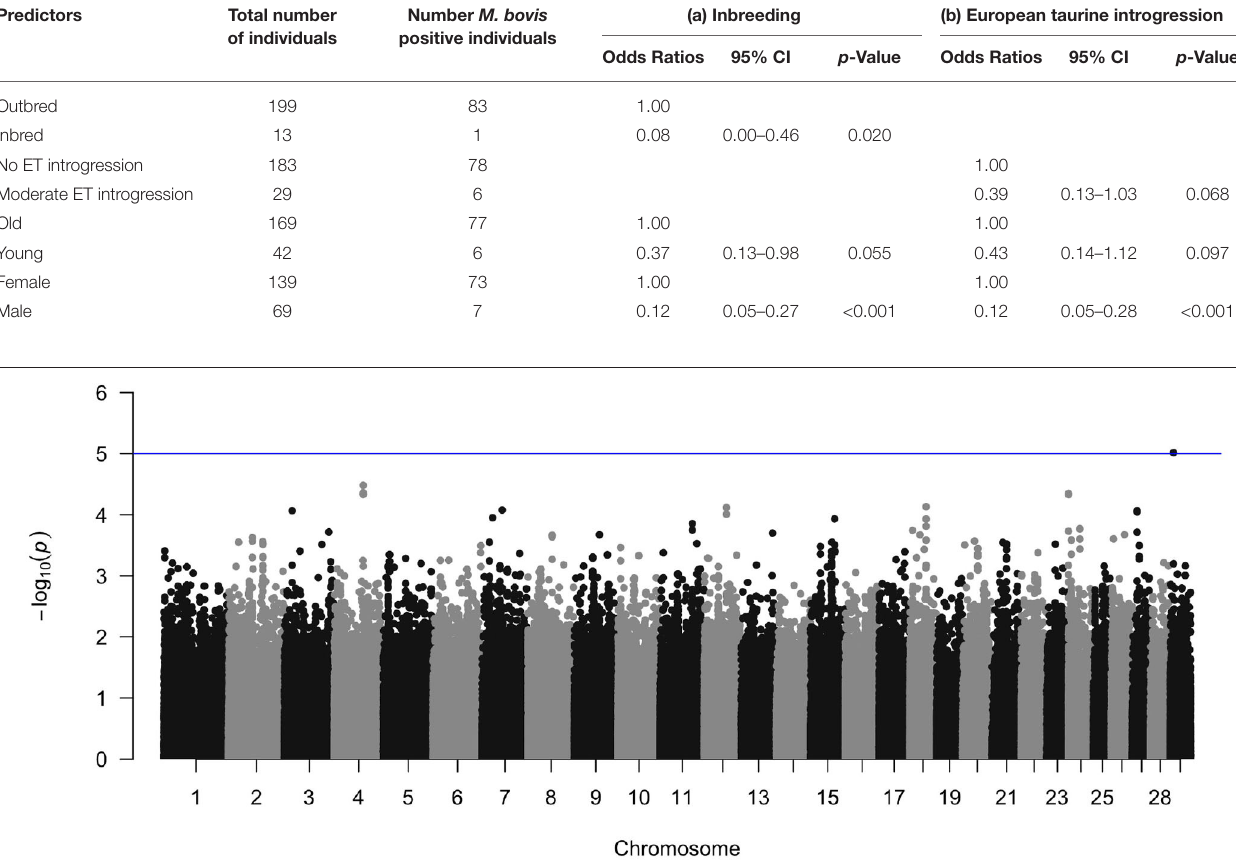
FIGURE 10 | Manhattan plot of the genome wide association between SNPs and M. bovis status after accounting for age, sex, breed, and the first three principal components as covariates. The blue line represents the suggestive significance line of log(p) < 1 × 10 − 5